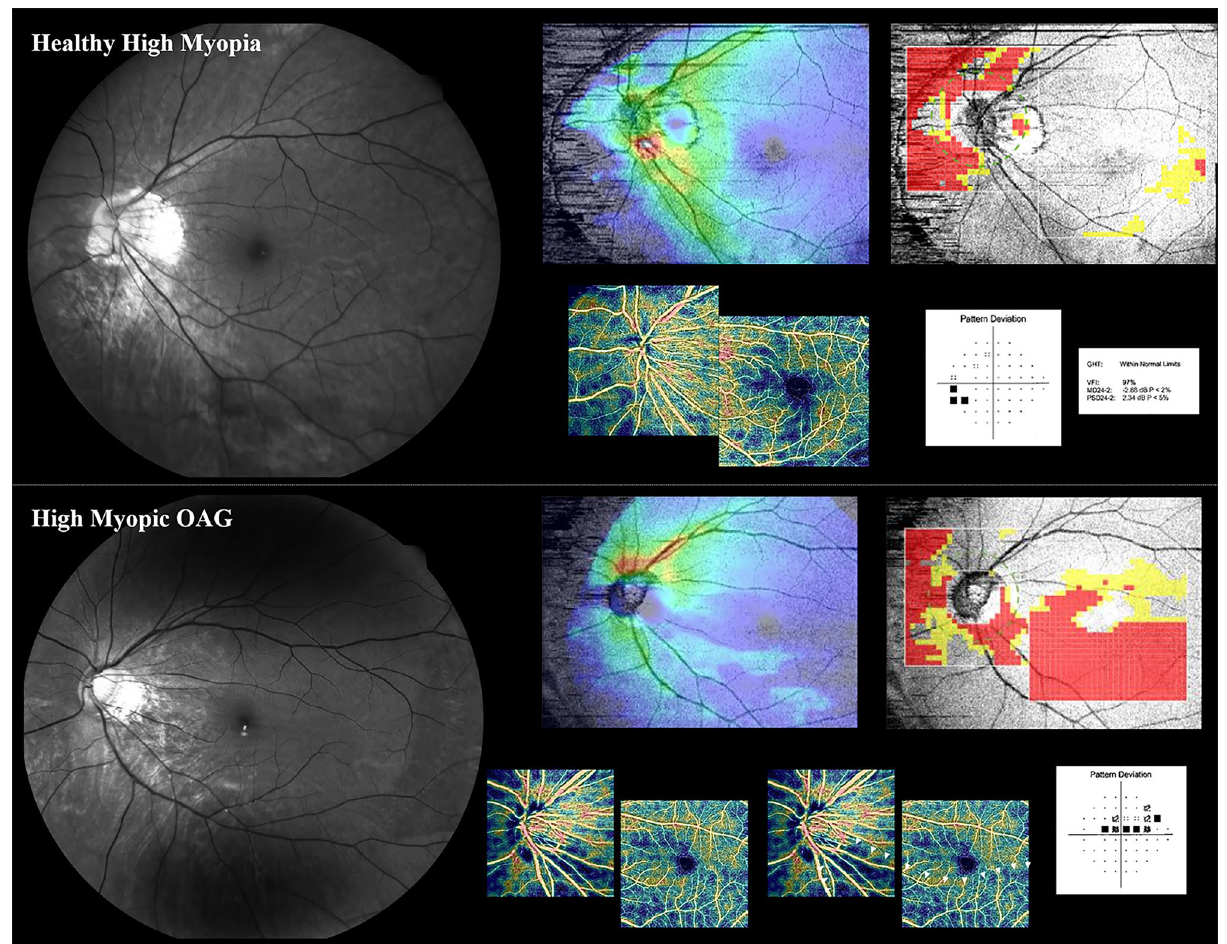
Figure 2. Example of highly myopic eyes in patients (upper row: male/56, −8.625 D, Axial length: 27.80 mm) (lower row: male/26, axial length: 27.86 mm, s/p LASEK). In the left eye of lower row, inferotemporal defect in vessel density is visible in the OCTA-PanoMap and consistent with the superior defect on the HVF pattern deviation map. Therefore, the diagnosis of glaucoma is made. In the upper row, however, any attenuation in vessel density is not visible in the OCTA-PanoMap and consistent with the absence of scotoma on the HVF pattern deviation map. Many red and yellow pixels (false positives) appear in the wide-field deviation map on that eye. HVF Humphrey visual fields, OCTA optical coherence tomography